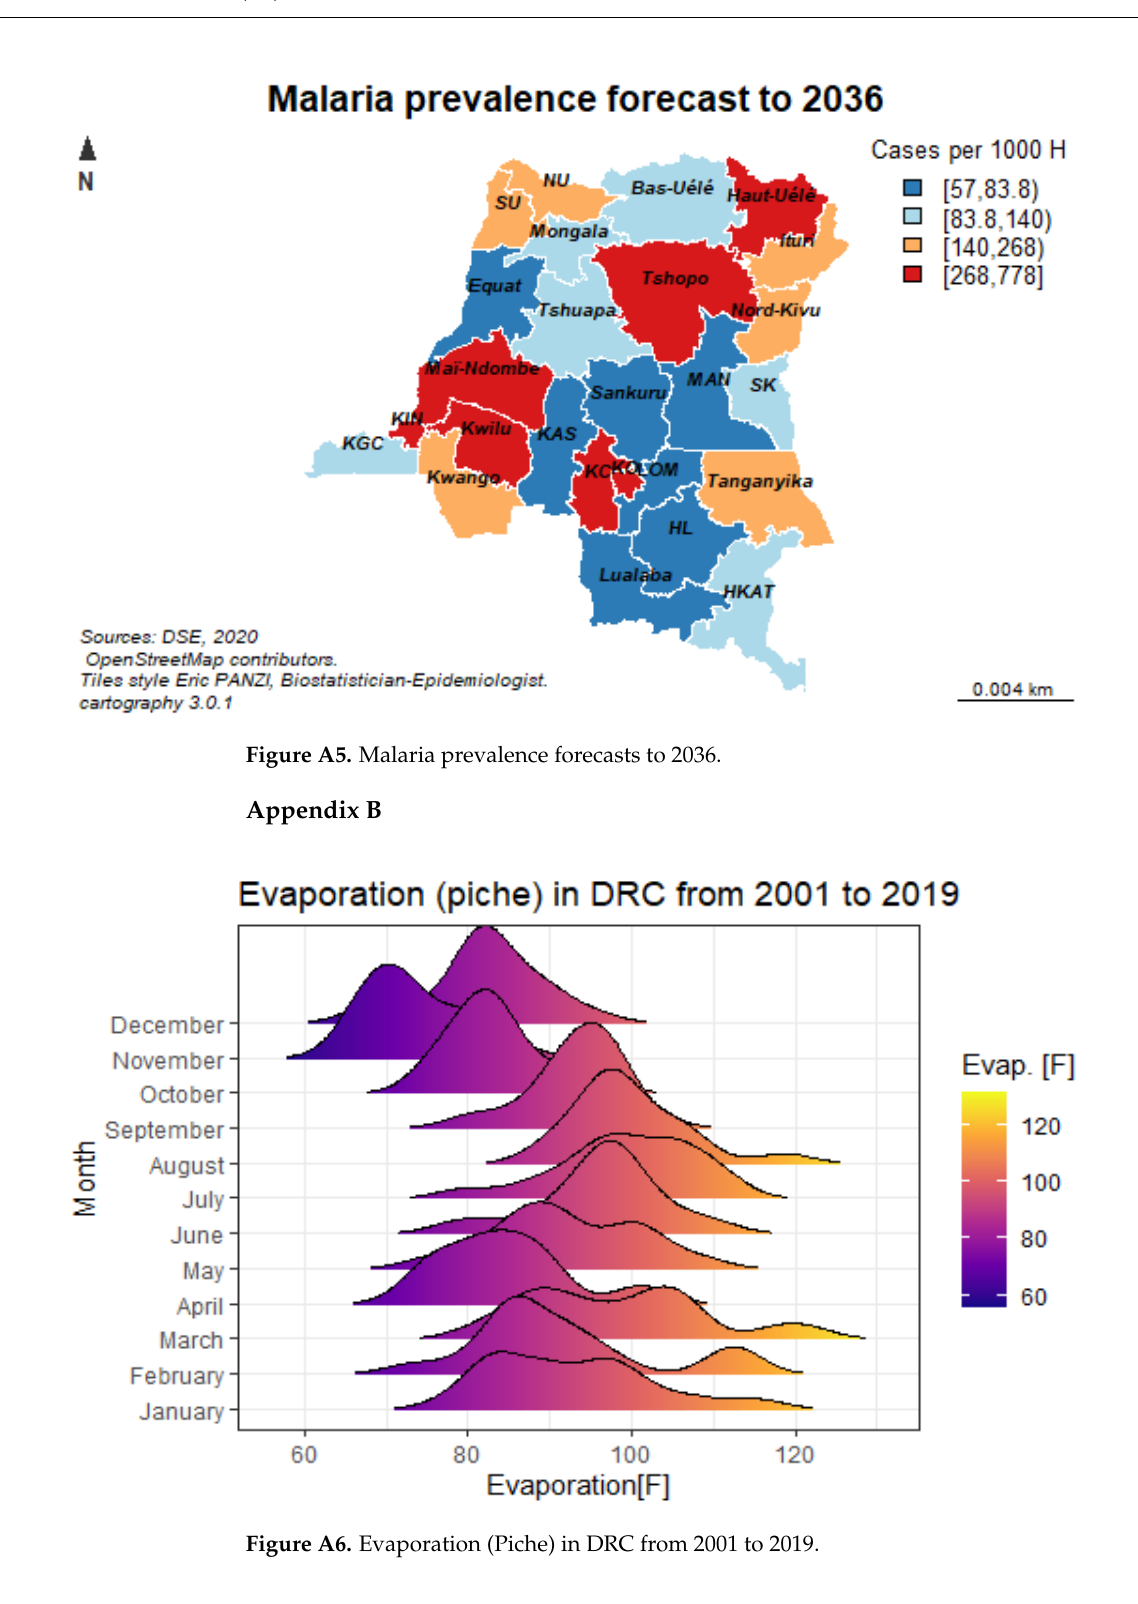
Figure A6. Evaporation (Piche) in DRC from 2001 to 2019.